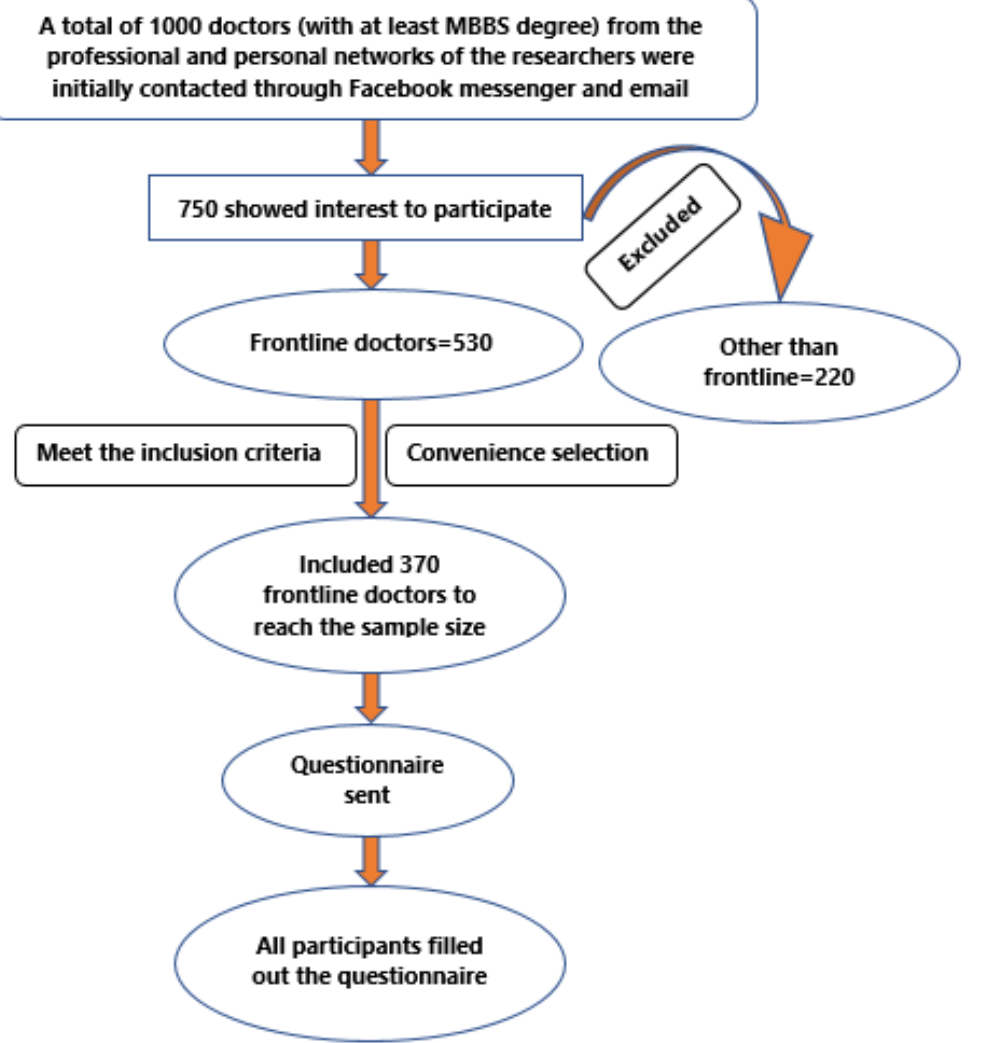
Figure 1. Flowchart for the enrollment and follow-up of